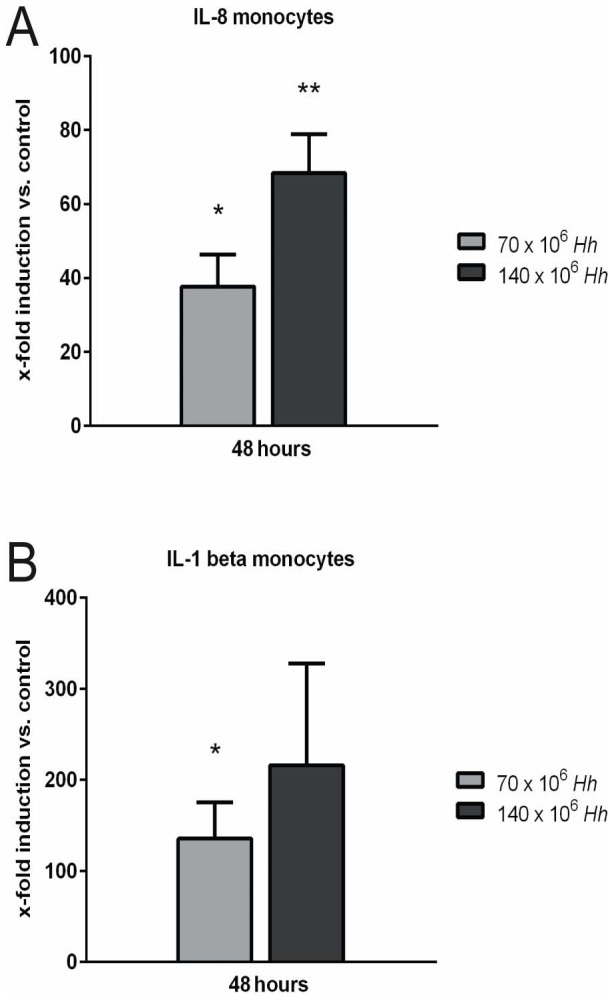
Primary human hepatocyte (PHH) conditioned media infected with H. hepaticus activate monocytes.Human CD14+ monocytes were isolated from peripheral blood of healthy donors and seeded at 10.000 cells/well. Monocytes were stimulated 24 hours with 100 µl of centrifuged PHH conditioned media infected with H. hepaticus at a MOI of 50 (70×106 Hh) or 100 (140×106 Hh) bacteria per hepatocyte for 48 hours (n = 3). Real-time RT PCR of monocytes revealed a dose-dependent increase of the mRNA expression of (A) Interleukin-1 beta (IL-1 beta) and (B) Interleukin-8 (IL-8). Cytokine mRNA is expressed as the fold induction compared to untreated control culture from the same hepatocyte donor for each time point (A-B). (n = 3). * = p<0.05 and ** = p<0.005 versus control.